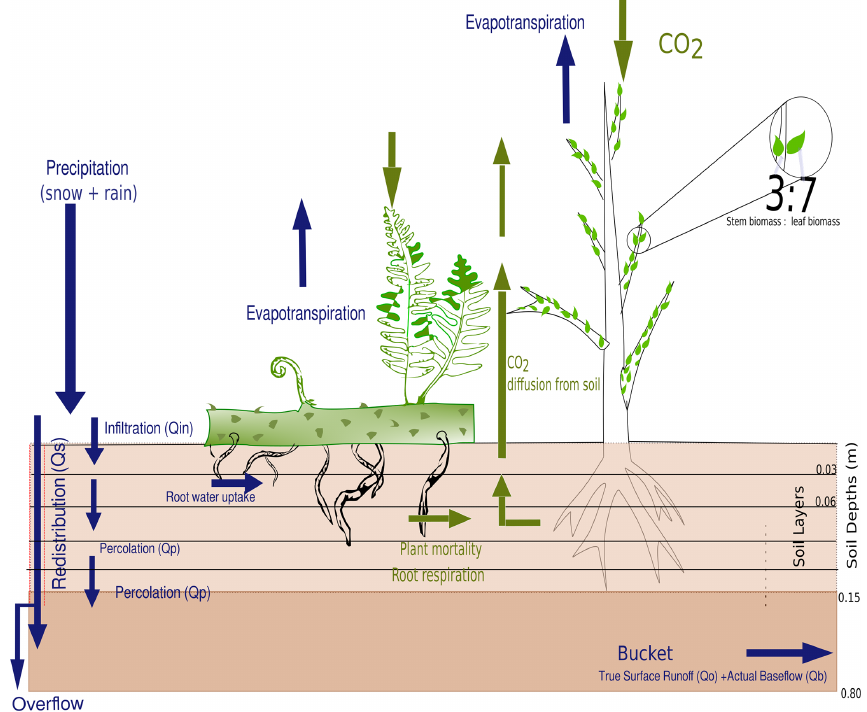
Figure 2. The root profile and general soil scheme comprising the five layers of top soil up to 15cm, followed by a bucket extending up to 0.65m, are represented along with the hydrological profile and carbon